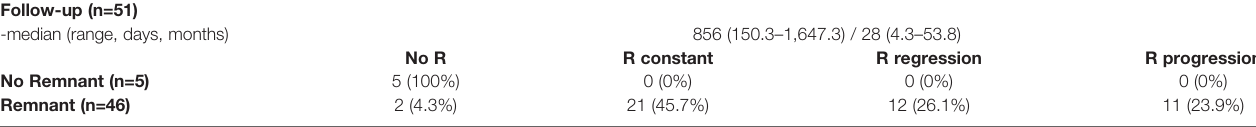
TABLE 3A | Anatomic outcome at follow-up. Follow-up (n=51) -median (range, days, months)